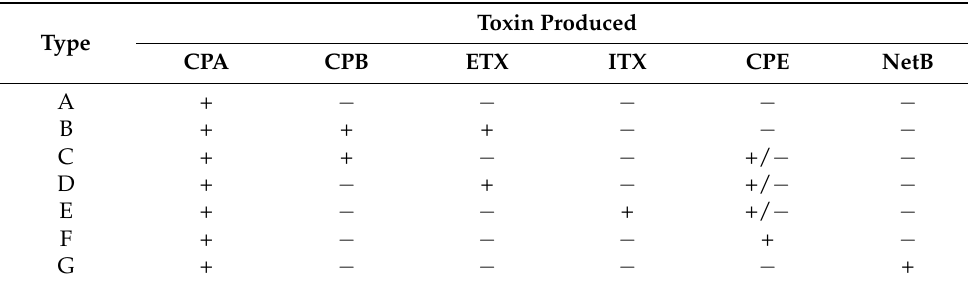
Table 1. Toxinotypes of Clostridium perfringens (adapted from [4]).